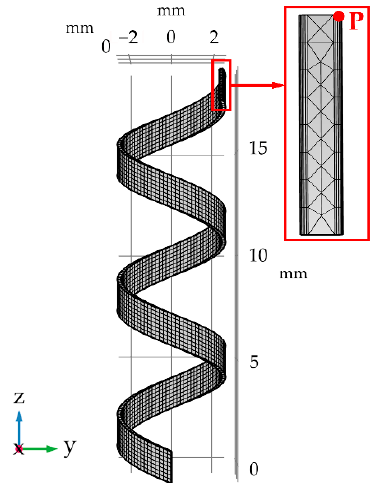
Figure 13. Mesh distribution of the helical IPMC